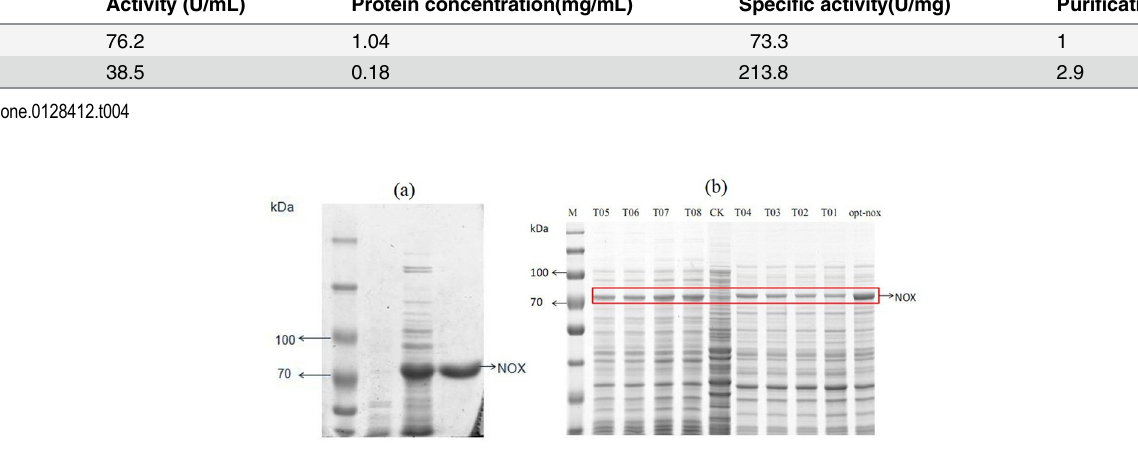
Fig 6. Purification of NOXs and characterization of the optimized opt- nox expression levels by SDS-PAGE. (a) 10% SDS-PAGE analysis of the purification opt- nox . M: protein marker; Lane 1: bacterium (harboring pET-32a) induced by IPTG; Lane 2: recombinant bacterium (harboring pET-32a-opt- nox ) induced by IPTG; Lane 3: purified opt- nox with His-tag. (b) Expression levels of optimized NOXs in BL21 (DE3) were analyzed by 10% SDS-PAGE. Lane M: molecular mass markers. Lane CK: BL21 (DE3) without nox gene. Lane T01 to T08 are different mutations. Lane opt- nox : the whole optimization of the nox sequence.